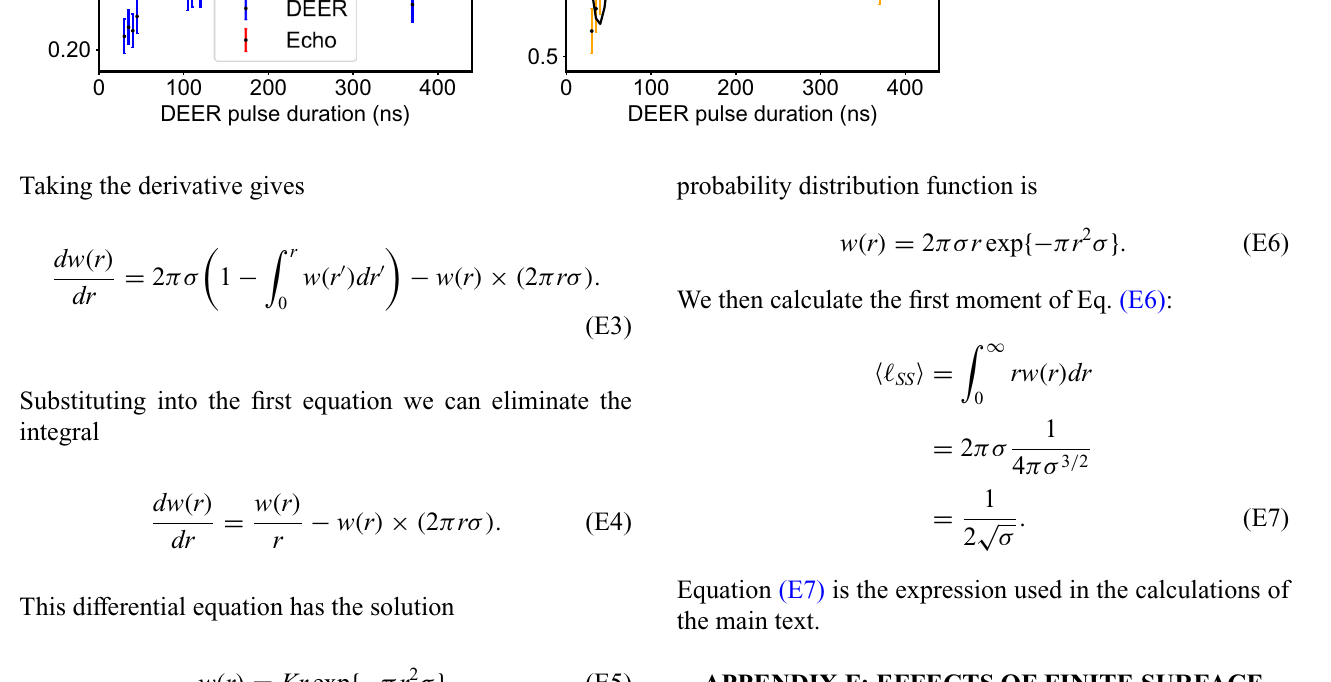
to extract a coherence decay time.